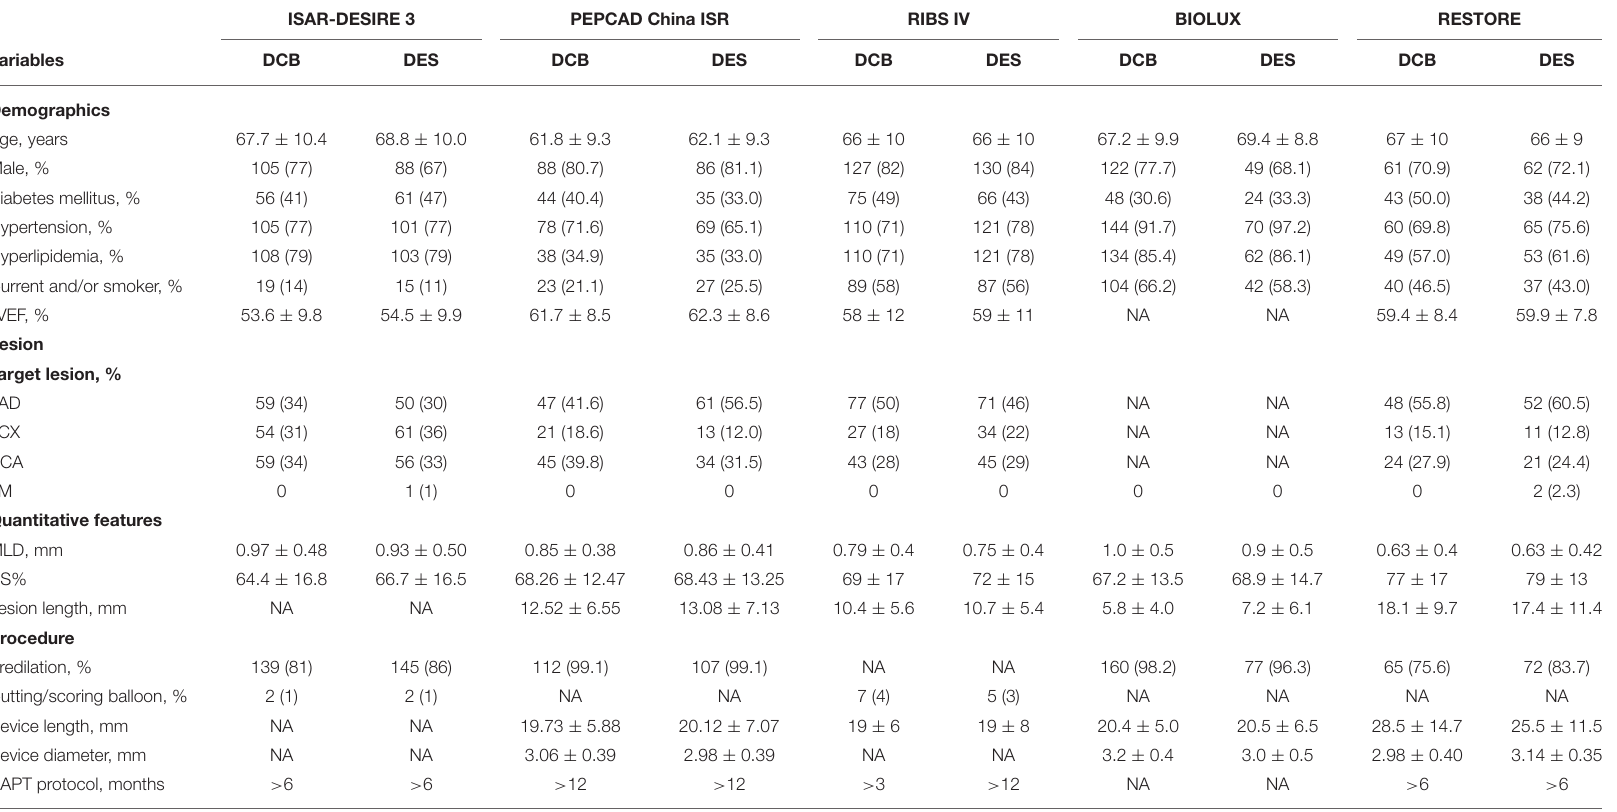
TABLE 3 | Baseline demographics, lesion, and procedure